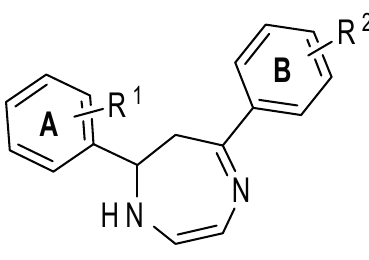
Figure 1. Chemical structure of diaryldiazepines.